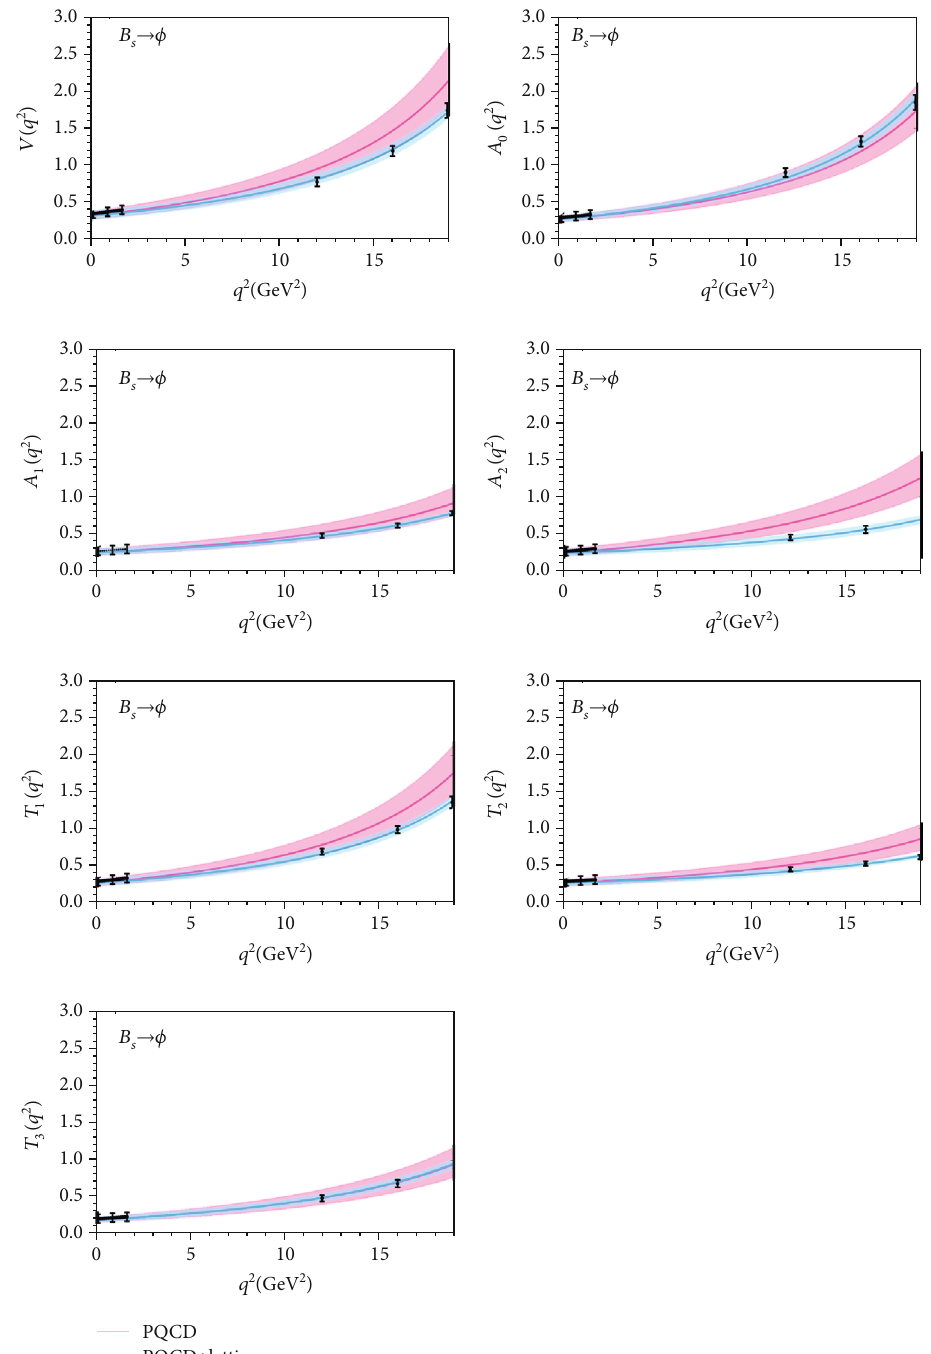
⟶ ϕ transition in the PQCD approach (red curves) and the “ PQCD Figure 1: Theoretical predictions of the relevant form factors for B s +Lattice ” approach (blue curves). The red (blue) shaded band represents the theory uncertainties. The black error bars in the low- q 2 region correspond to the PQCD predictions. The error bars in high- q 2 region are the lattice QCD